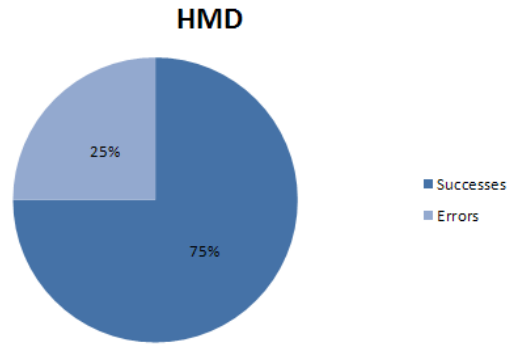
Success rate in the third test when the user wears the